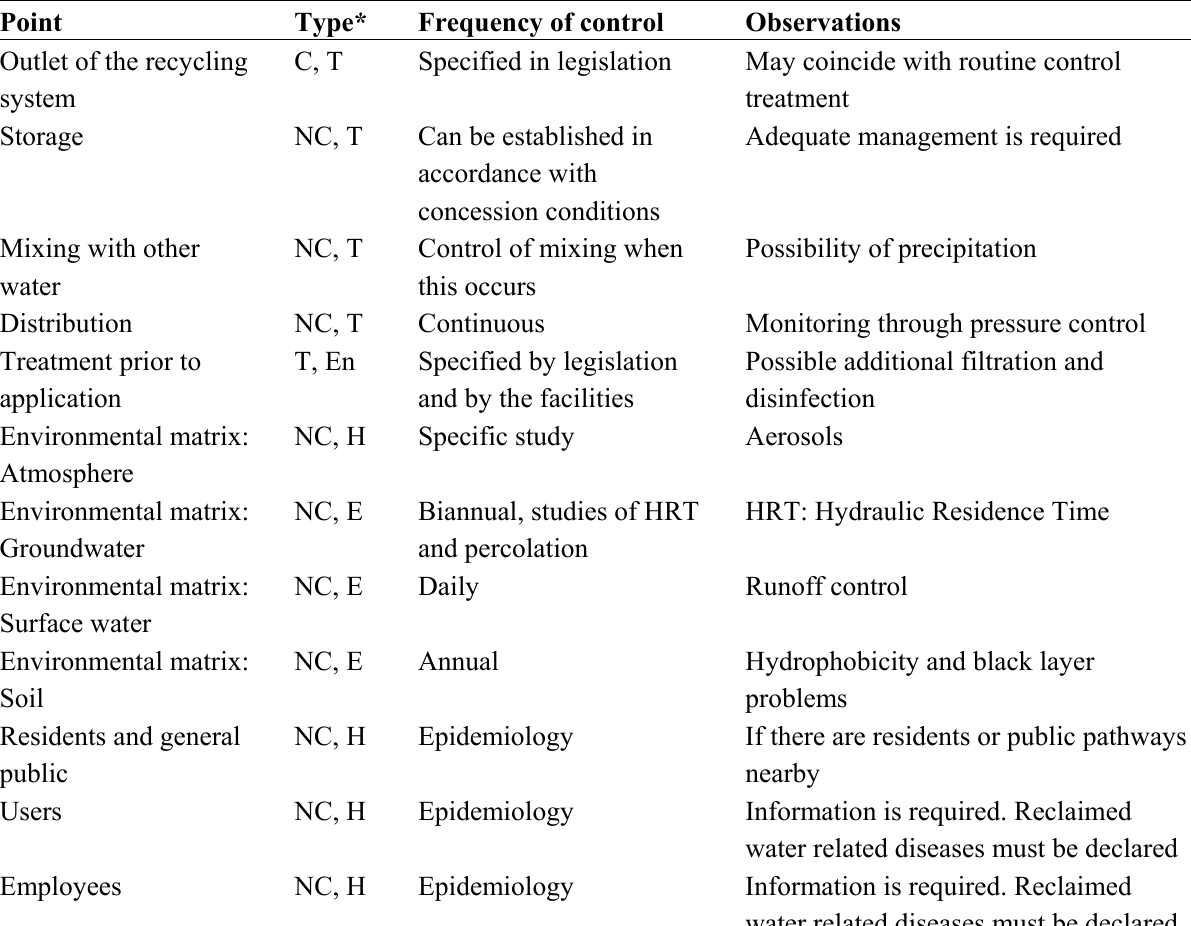
Table 20. Monitoring and control points for golf course